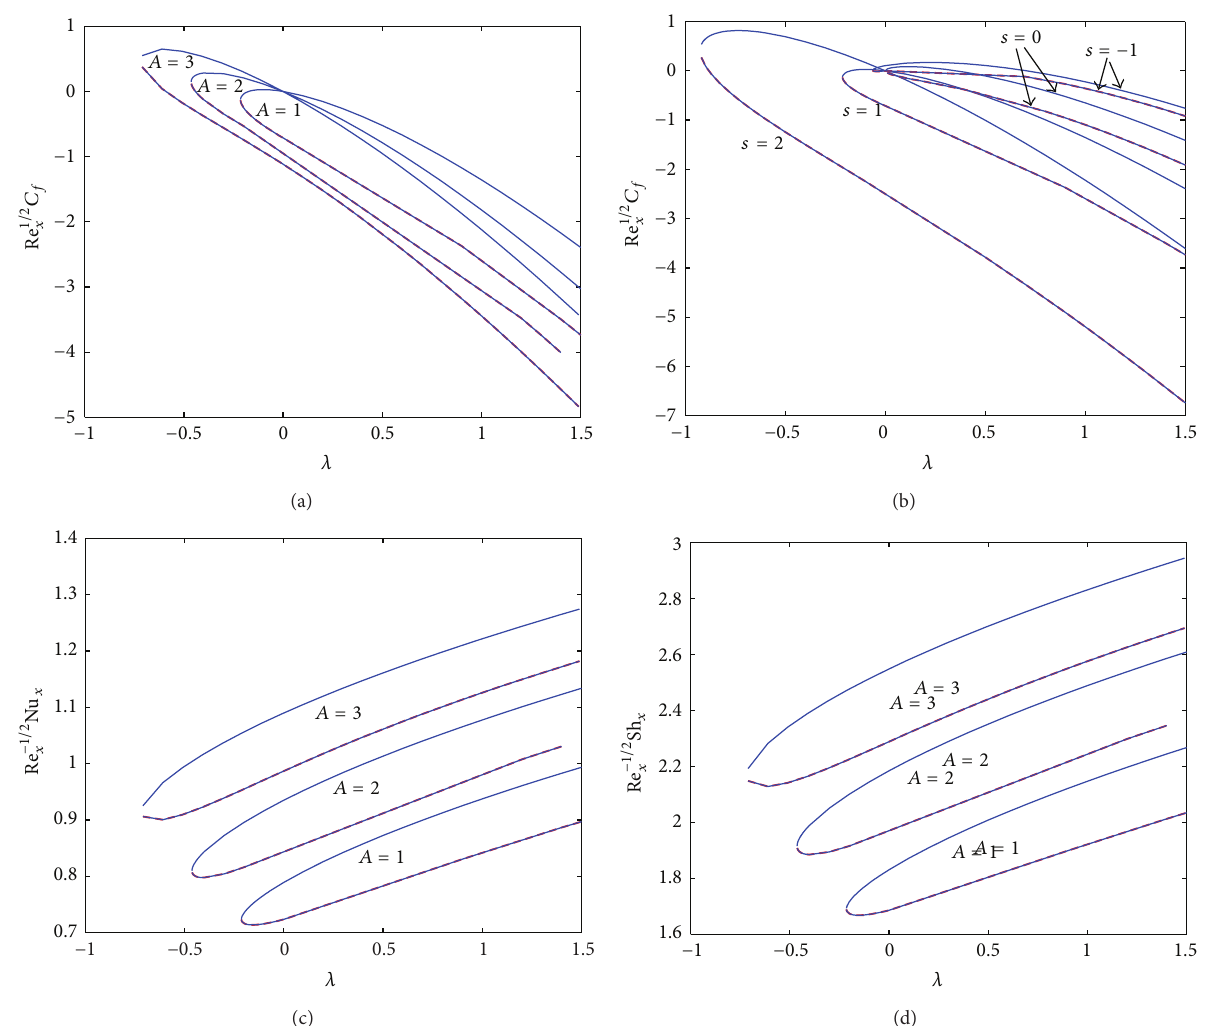
Figure 7: Variation of the local skin friction and local Nusselt and Sherwood numbers with 𝜆 for different values of 𝐴 and 𝑠 (dashes denote second solution; solid line denotes 1st